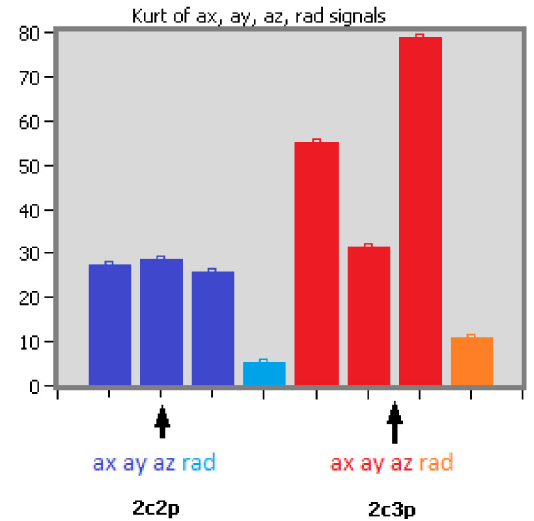
Figure 11. Radar and accelerometer signal kurtosis evolution for 2c2p and 2c3p gait